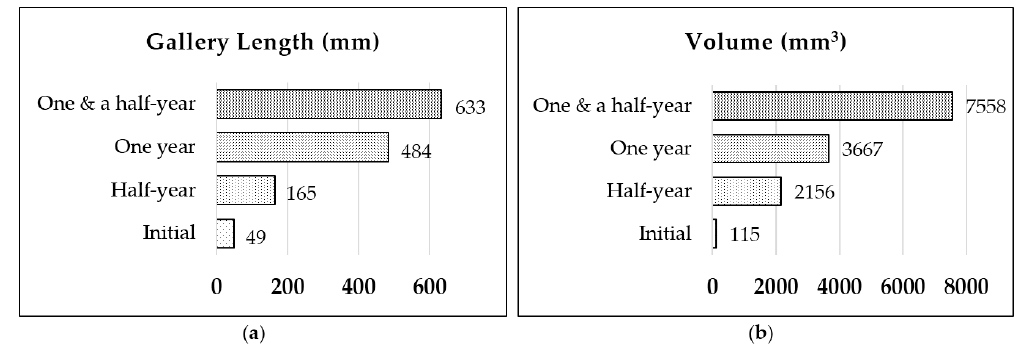
Figure 3. The properties of nest-gallery development in Spruce A timber: ( a ) gallery length (mm); and ( b ) volume (mm 3 ).